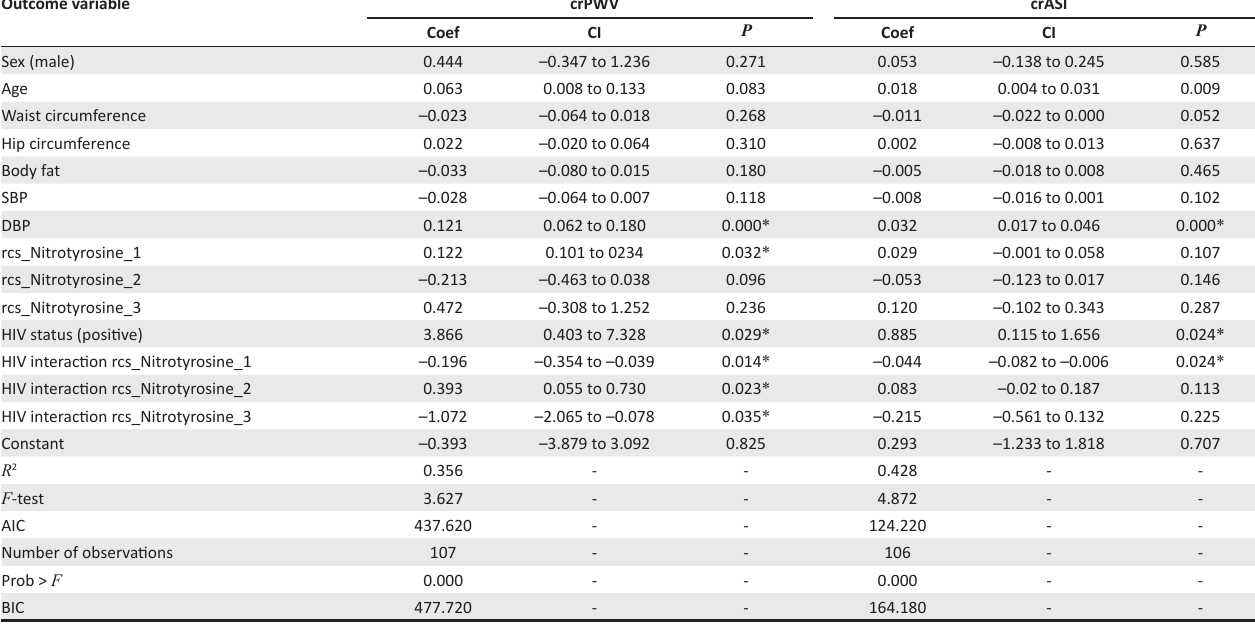
TABLE 3 : Multiple linear regression analyses of endothelial function and oxidative stress. Outcome